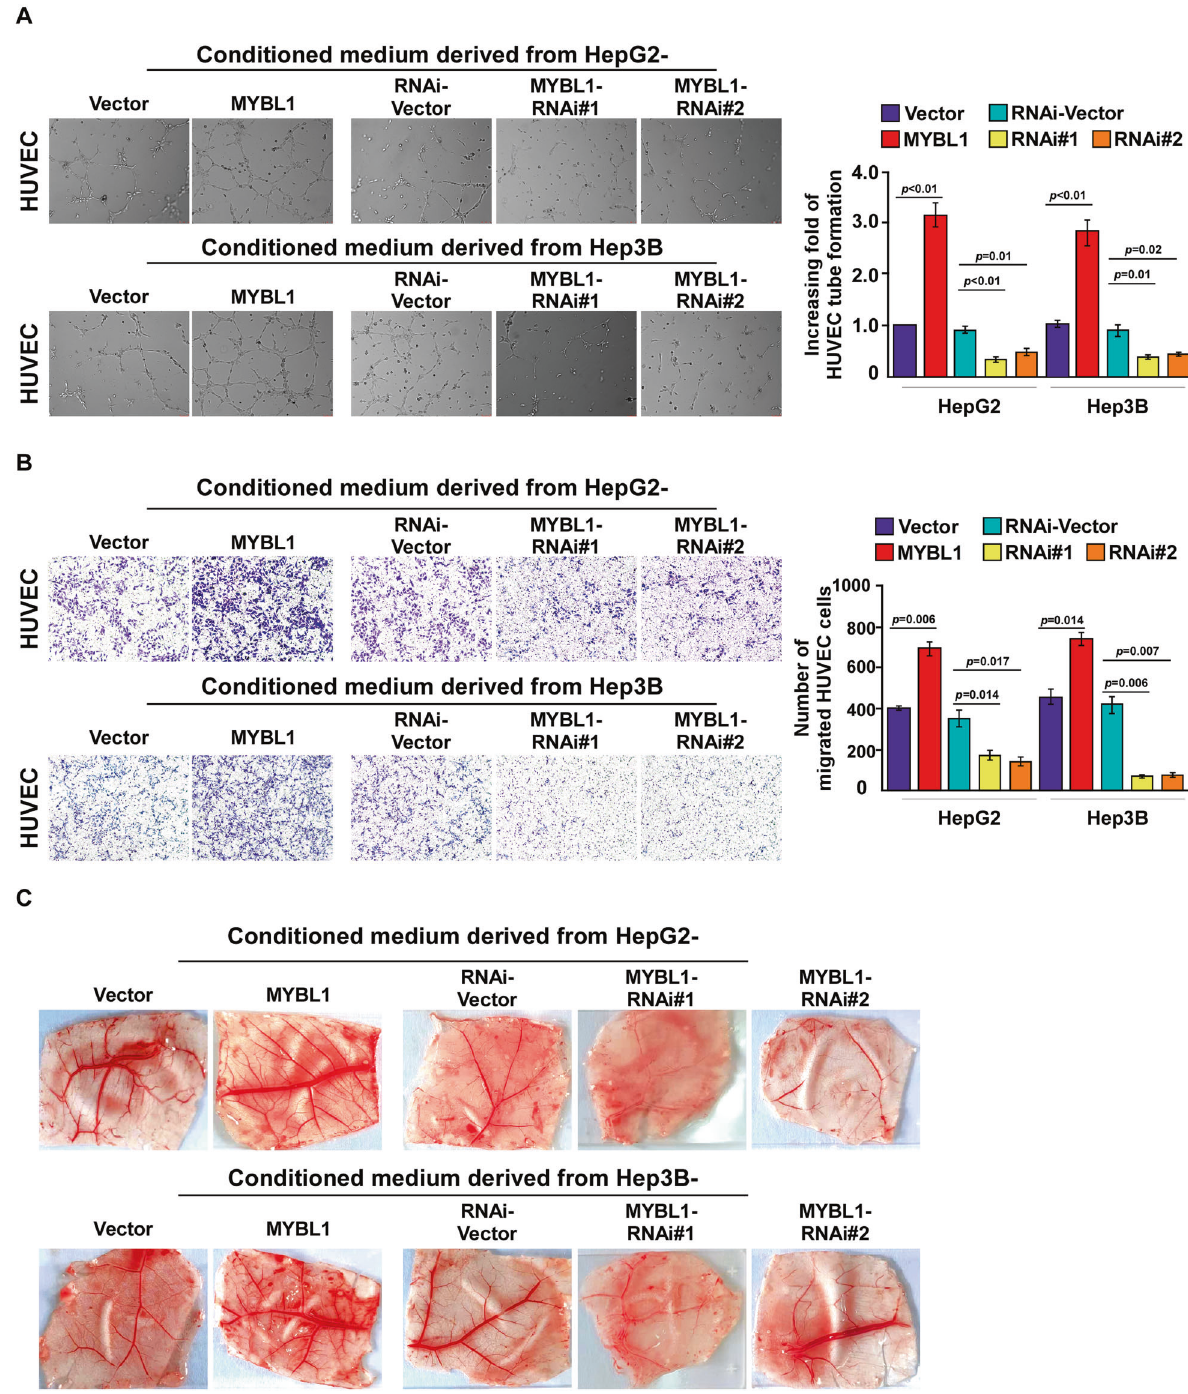
Fig. 2 Ectopic expression of MYBL1 promoted HCC angiogenesis in vitro. A The effect of MYBL1 on HUVEC tube formation with conditioned media from the indicated HCC cells. B The effect of MYBL1 on HUVEC cell migration with conditioned media derived from the indicated HCC cells. C Representative images of the blood vessels formed in the CAM assay, after stimulation with conditioned medium from the indicated cells. Each bar represents the mean ± SD of three independent experiments.